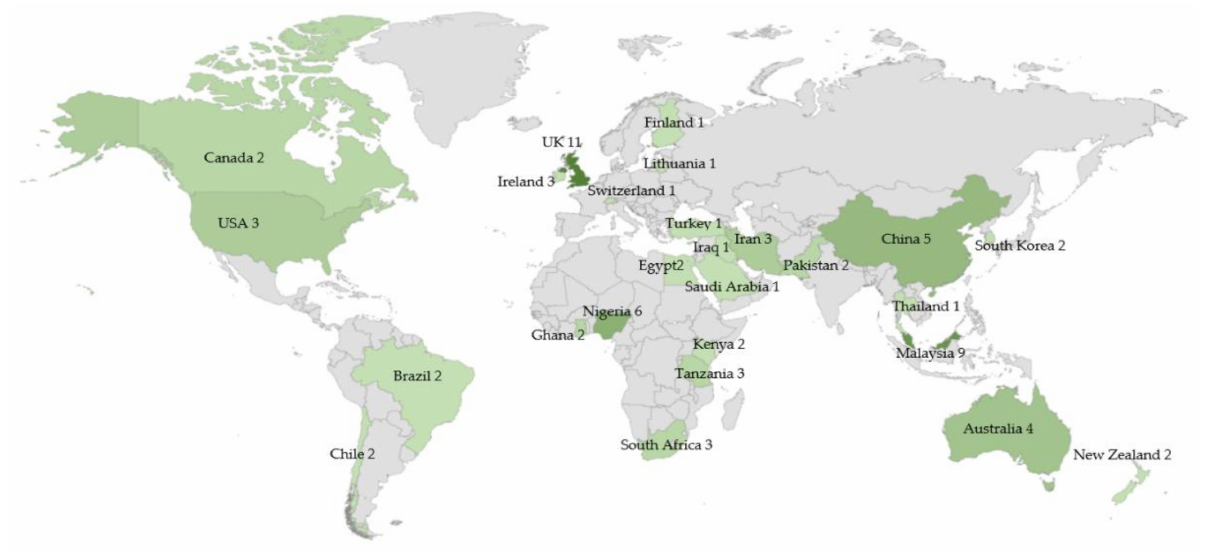
Figure 3. Publication territory in SIAH